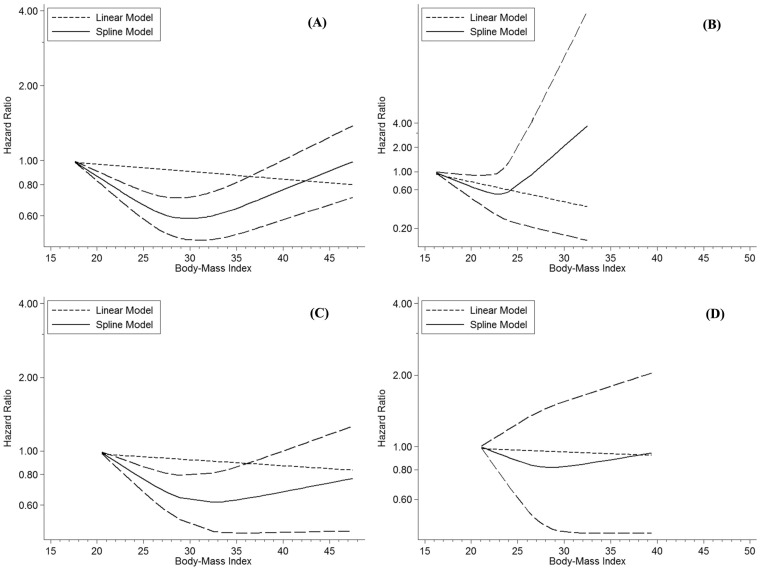
Subgroup analysis plots displaying non-linear dose-response relationships between body mass index (BMI) and all-cause mortality among patients with type 2 diabetes using pooled data from studies performed in (A) Western countries or (B) Asia, as well as those involving (C) patients with incident diabetes and (D) patients without smoking histories.